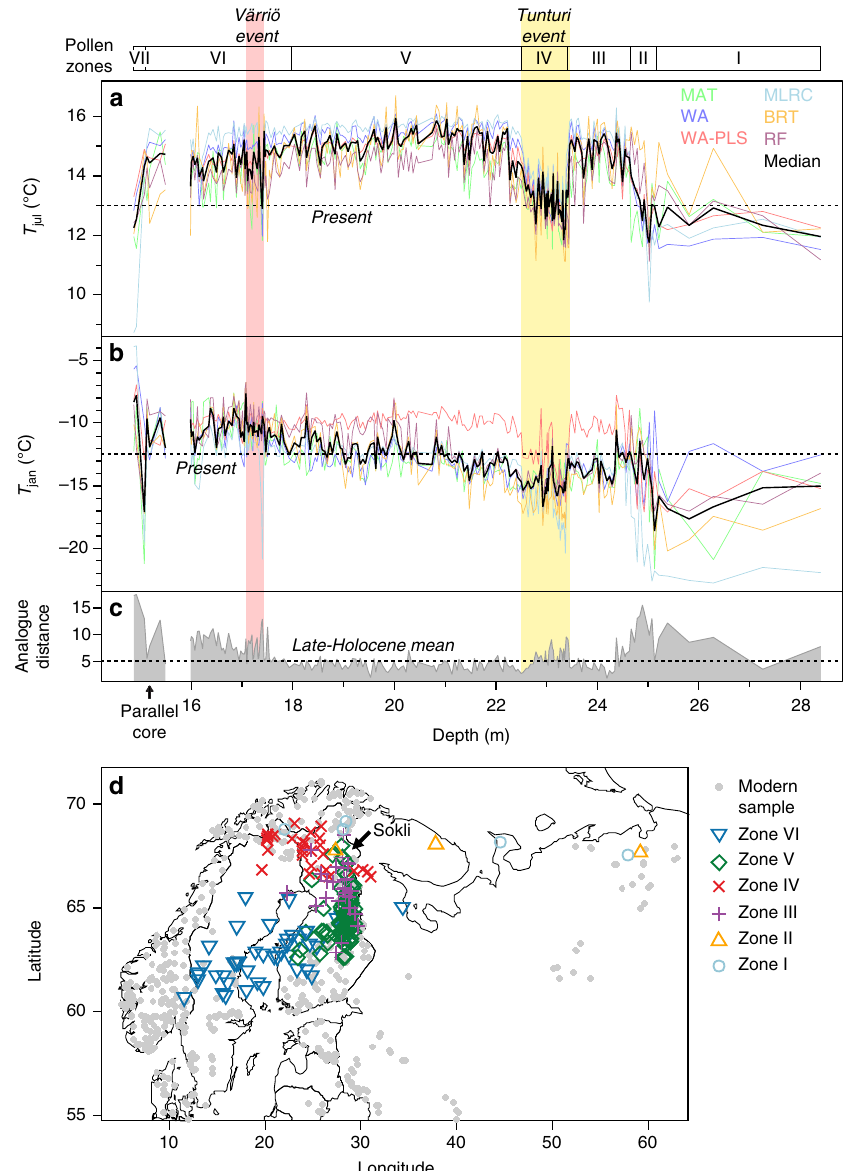
Fig. 3 Climate reconstruction based on the Eemian pollen data from Sokli. Reconstructions are prepared for ( a ) T jul and ( b ) T jan , using six different pollen – climate calibration models (see Methods for details), and summarised as a median of all six reconstructions (black curve). Abrupt climate events are indicated with coloured bars. The parallel core covering the end of the Eemian is shown with 3× exaggeration of the depth scale. c Analogue quality (squared chord distance 68 ) between each fossil pollen sample and the best matching modern pollen calibration sample. The dashed line indicates the mean analogue quality found for Late-Holocene samples from a nearby lake core 69 . d Geographic locations of best modern analogues found for each fossil pollen sample. Fossil samples use symbols based on their pollen zone, and are positioned at the mean latitude and longitude (weighted by the analogue quality) of the fi ve most compositionally similar modern pollen samples. For clarity, only fossil samples with relatively good modern analogues are shown (compositional distance to best modern analogue less than 2× the mean analogue distance found for Late-Holocene samples; see panel c ). Locations of the available modern samples and the Sokli fossil site are also